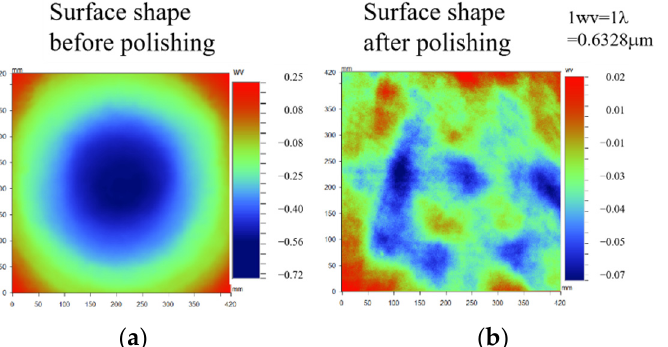
Figure 15. Experimental results of element surface shape measurement. ( a ) PV = 0.9 7 λ ; ( b ) PV = 0.09 λ .